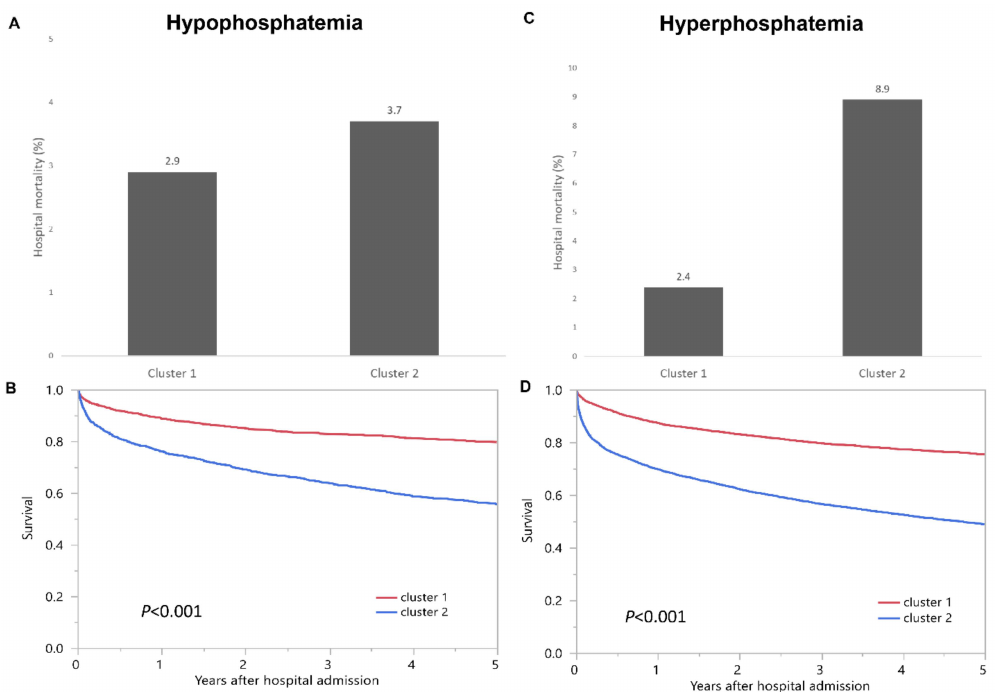
Figure 4. ( A ) Hospital mortality and ( B ) one-year and five-year mortality among two clusters of admission hypophos- phatemia; ( C ) Hospital mortality and ( D ) one-year and five-year mortality among two clusters of admission hyperphos-